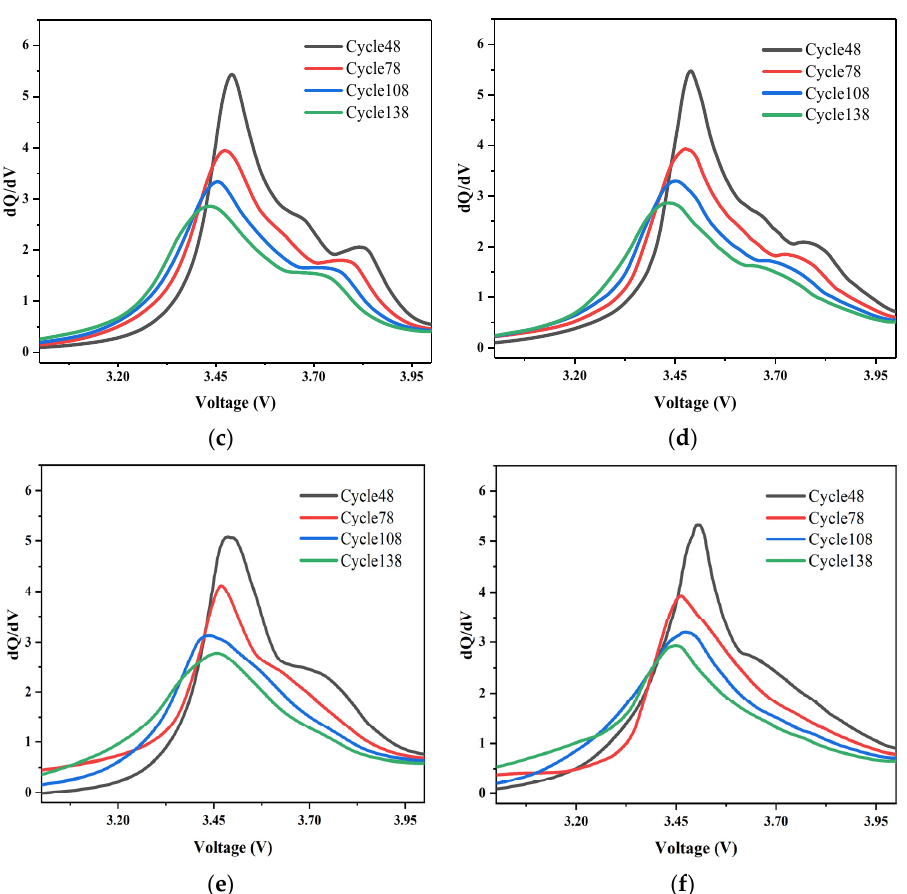
Figure 3. ICA curves after different wavelet filtering. ( a ) Layers:5, wave:sym6. ( b ) Layers:5, wave:db4. ( c ) Layers:6, wave:sym6. ( d ) Layers:6, wave:db4. ( e ) Layers:7, wave:sym6. ( f ) Layers:7, wave:db4.